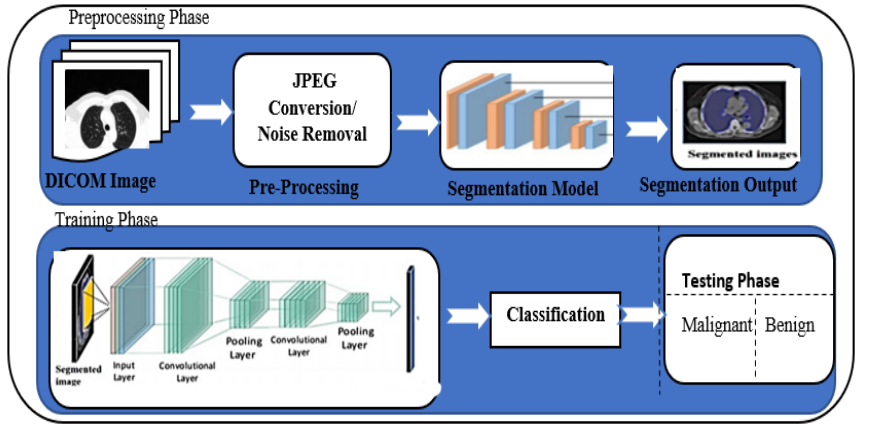
Figure 2. Framework for the detection of Lung cancer for a CAD System [28].